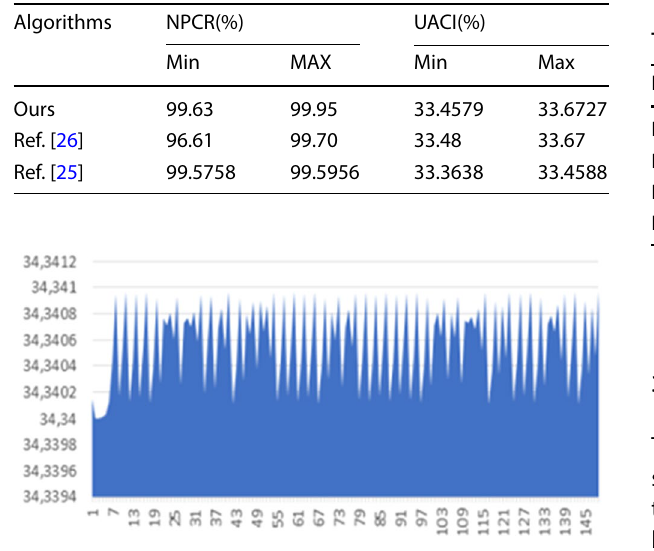
Fig. 15 UACI distribution